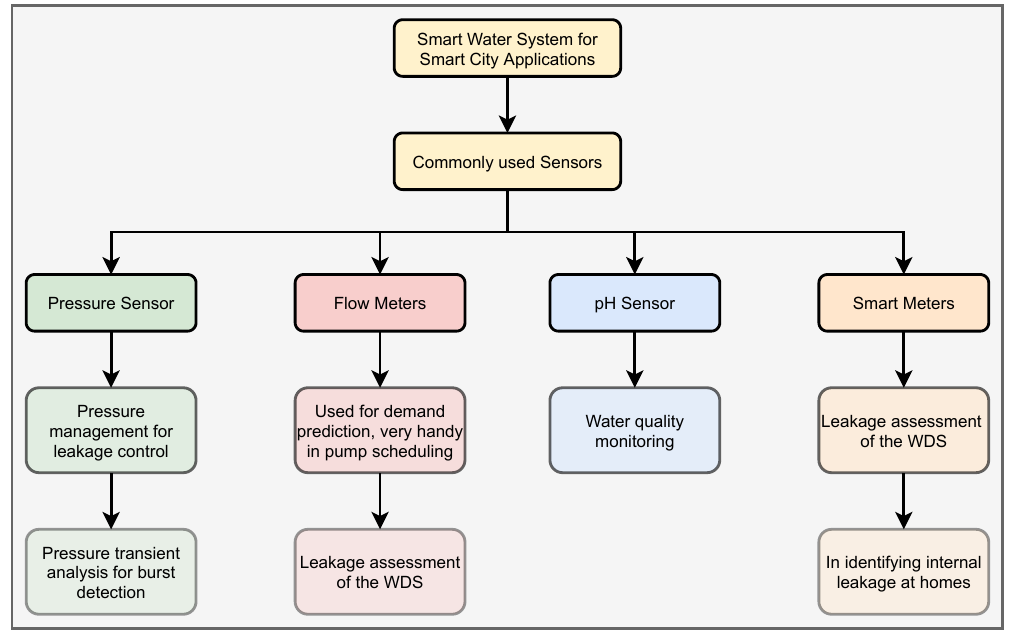
Figure 2. Sensors and their applications in smart